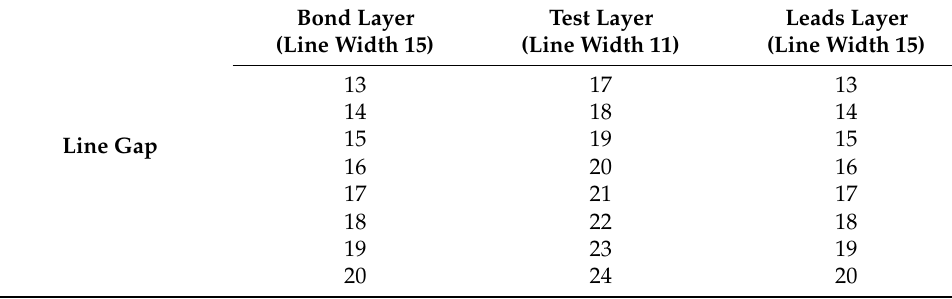
All data in the table are in